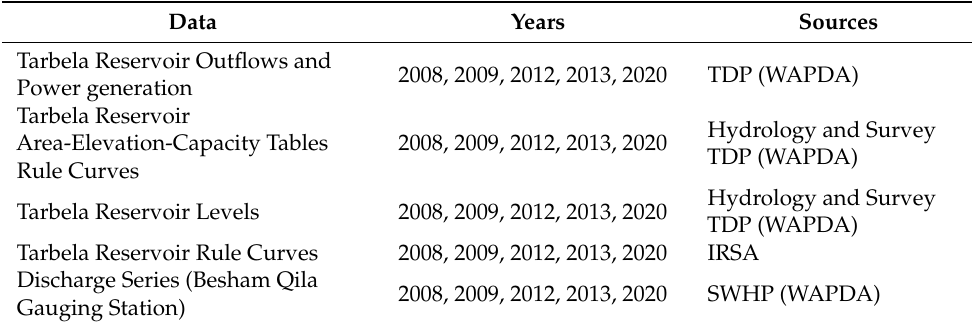
Table 4. Tarbela dam and reservoir data collection